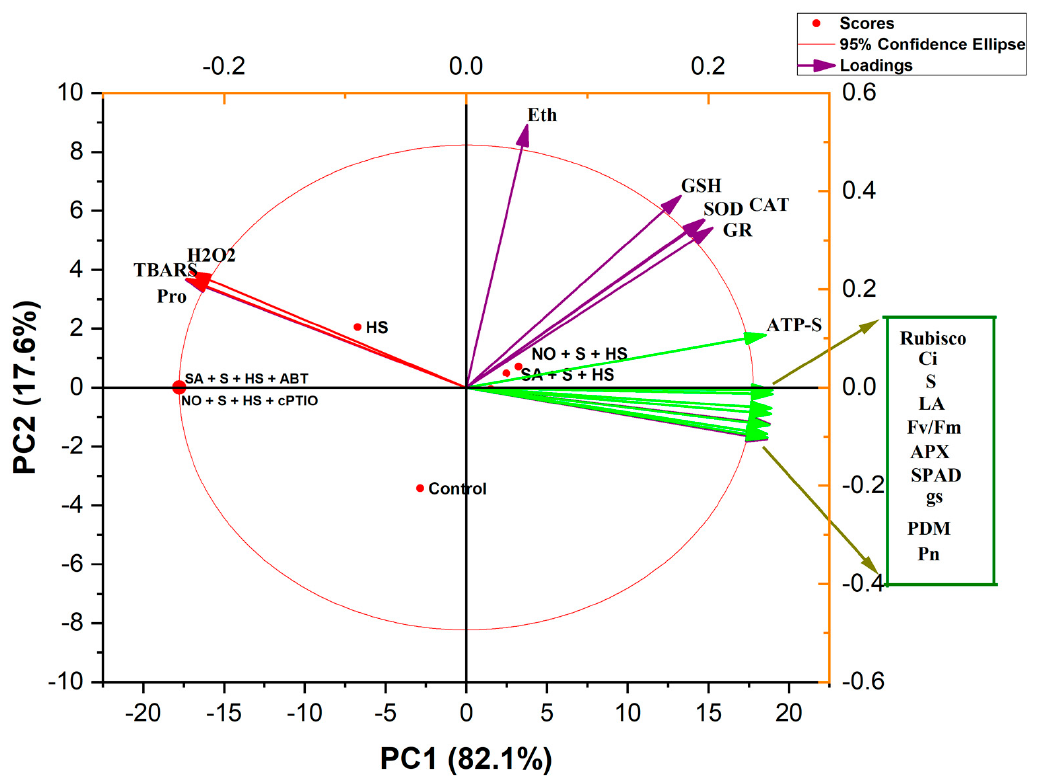
Figure 4. Principal component analysis (PCA) biplot for growth and physio-biochemical traits of Triticum aestivum plants. The treatments included control, heat stress (HS; 40 °C for 6 h daily for 15 days), NO + S + HS, SA + S + HS, NO + S + HS + cPTIO, SA + S + HS + ABD. The variables included ethylene (Eth), thiobarbituric acid reactive substances (TBARS), proline (Pro), hydrogen peroxide (H 2 O 2 ), superoxide dismutase (SOD), glutathione reductase (GR), reduced glutathione (GSH), ATP-sulfurylase (ATP-S), Rubisco, leaf S (sulfur), net photosynthesis (Pn), stomatal conductance (gs), intercellular CO 2 concentration (Ci), maximal PSII efficiency (F v /F m ), plant dry mass (PDM) and leaf area (LA).